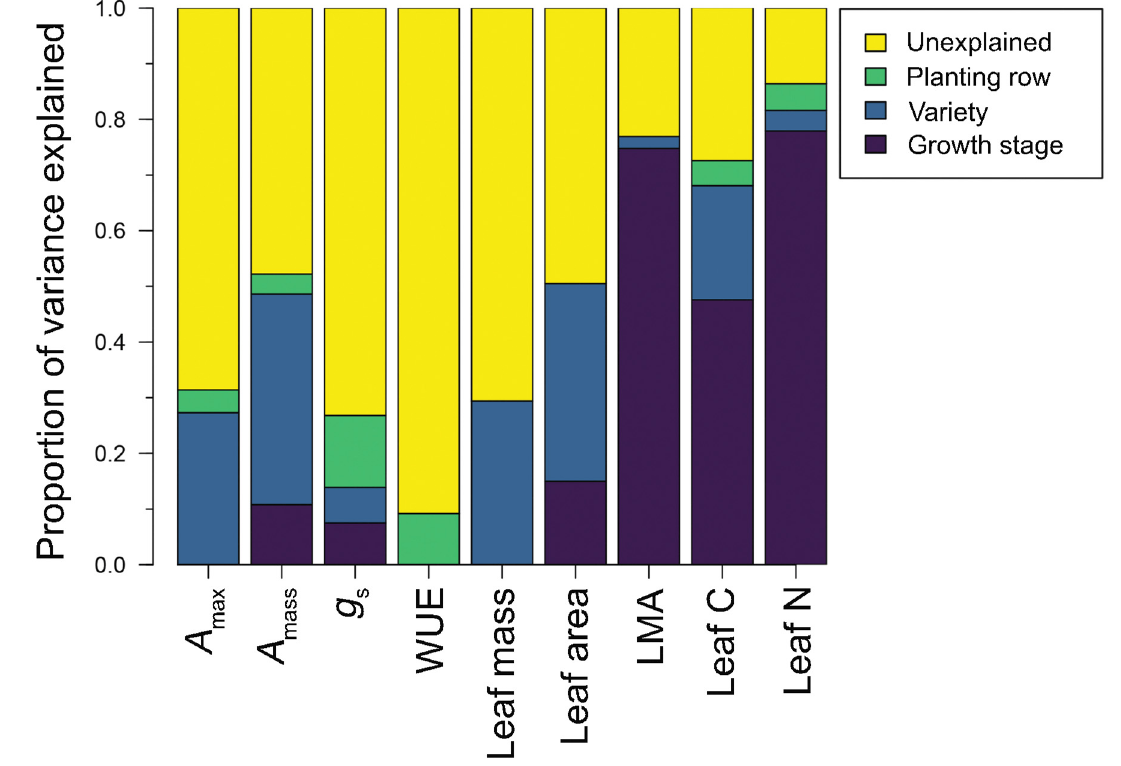
Figure 2. Variance partitioning of nine leaf traits measured across five common wine grape varieties, at two growth stages, and across spatial locations (i.e., planting rows). Heights of the different bar segments correspond to the proportion of total trait variation in each trait (where n = 90 leaves for all traits), as determined by a variance partitioning procedure. Variance components presented here visually correspond to the numerical values presented in Table 1. Trait abbreviations are as follows: A max : light saturated maximum photosynthetic rate on a per-unit leaf area basis; A mass : light saturated maximum photosynthetic rate on a per-unit leaf mass basis; g s : stomatal conductance; WUE: instantaneous water use efficiency; LMA: leaf mass per unit area.